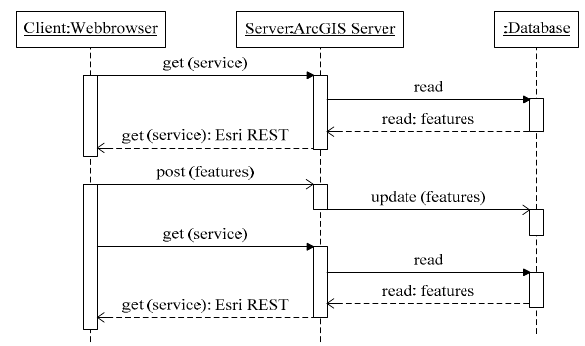
Figure 9. Draft sequence diagram for editing web